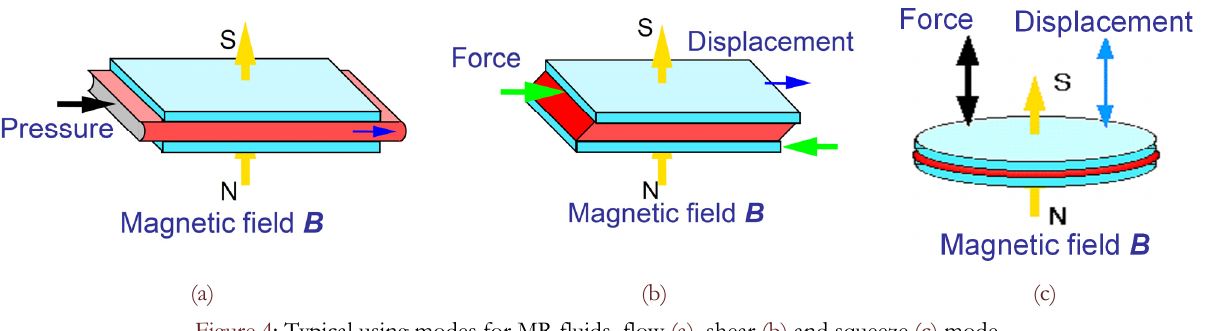
Figure 4: Typical using modes for MR fluids, flow (a), shear (b) and squeeze (c) mode.